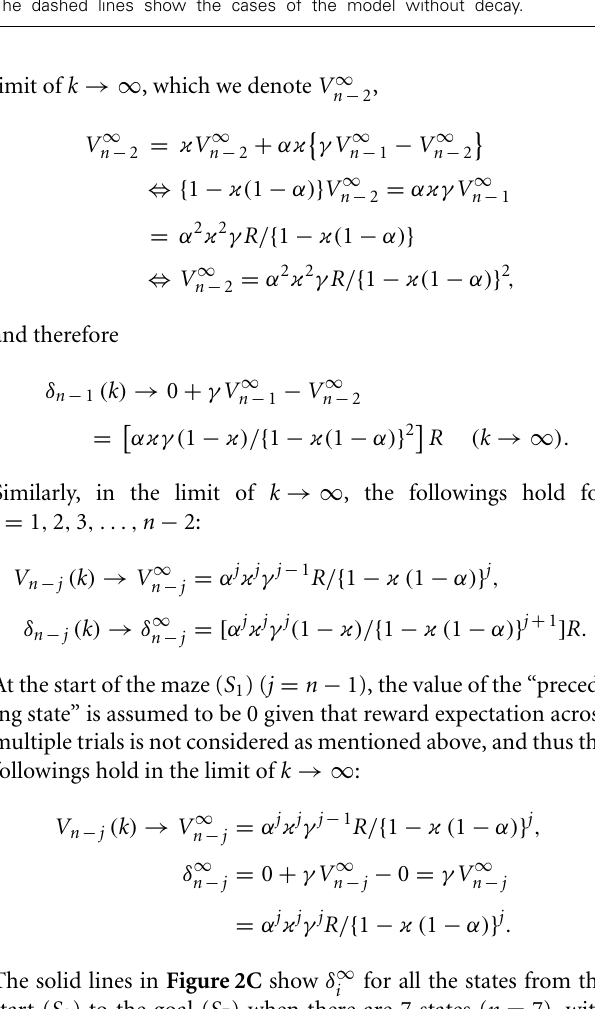
The solid lines in Figure 2C show δ ∞ for all the states from the i start ( S 1 ) to the goal ( S 7 ) when there are 7 states ( n = 7), with varying the learning rate ( α ) ( Figure 2Ca ), time discount factor ( γ ) ( Figure 2Cb ), decay factor ( (cid:5) ) ( Figure 2Cc ), or the amount of reward ( R ) ( Figure 2Cd ) (unvaried parameters in each panel were set to the middle values: α = 0 . 6, γ = 0 . 8 ( 1 / 6 ) , (cid:5) = 0 . 75, in the model without incor- and R = 1); the dashed lines show δ ∞ i porating the decay for comparison. As shown in the figures, in the cases with decay, the eventual (asymptotic) values of RPE after the convergence of learning entail gradual ramping toward the